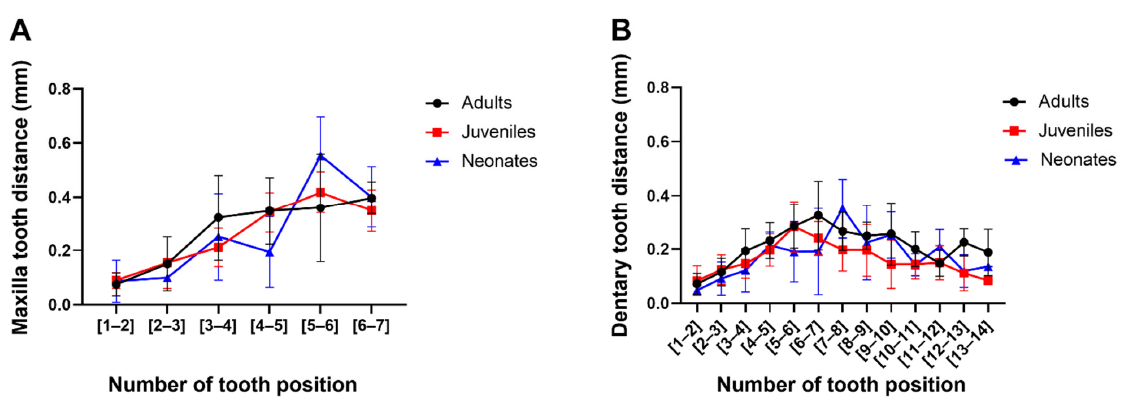
Figure 4. Variation of the distance between teeth of ( A ) maxilla and ( B ) dentary bones in Galvarinus ch. chilensis . Data shown are mean ± SD from adults (N = 9), juveniles (N = 9), and neonates (N = 4).